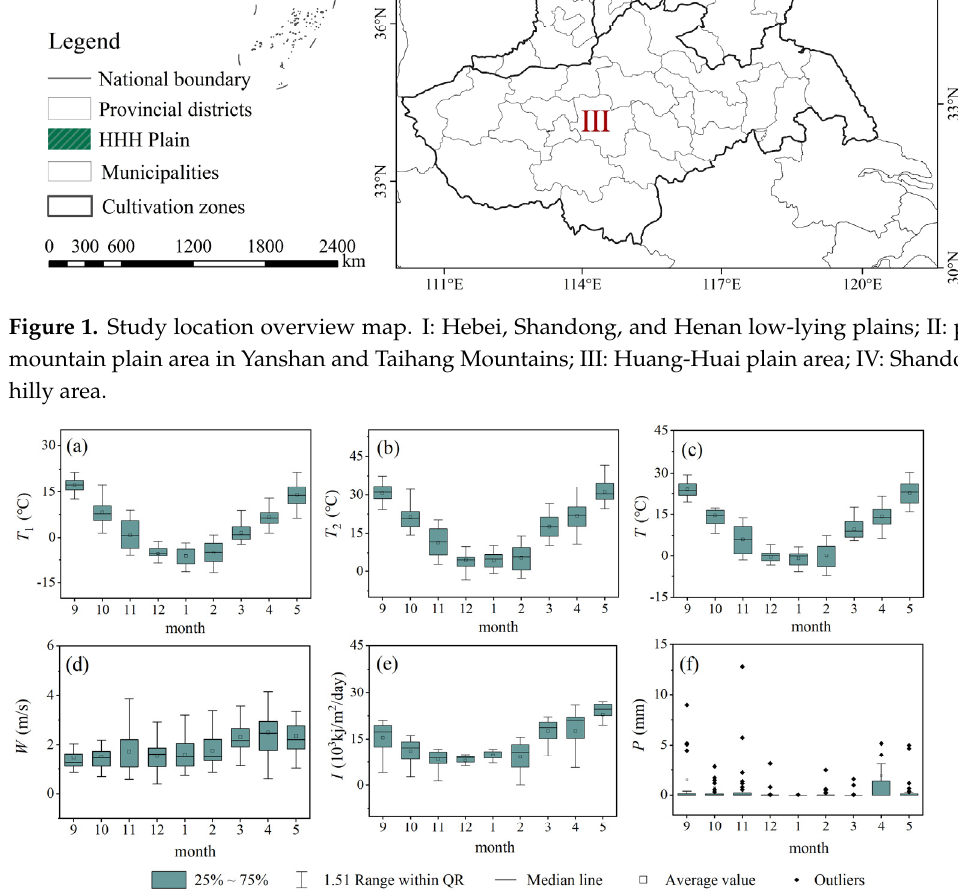
Figure 2. Distribution of meteorological variables. ( a ) T 1 : Daily minimum temperature. ( b ) T 2 : Daily maximum temperature. ( c ) T : Daily average temperature. ( d ) W : Average wind speed. ( e ) I : Solar radiation. ( f ) P : Average precipitation.